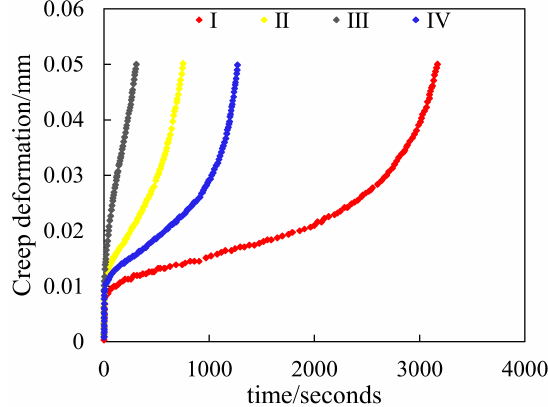
Figure 16. Results of static load creep